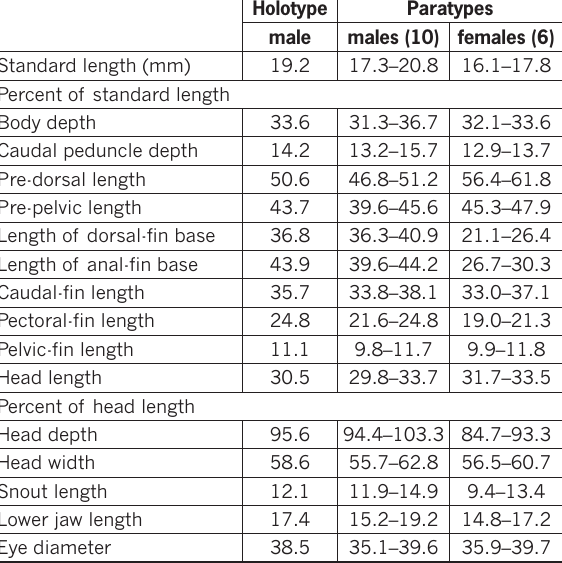
Table 2. Morphometric data of Spectrolebias gracilis (sp.